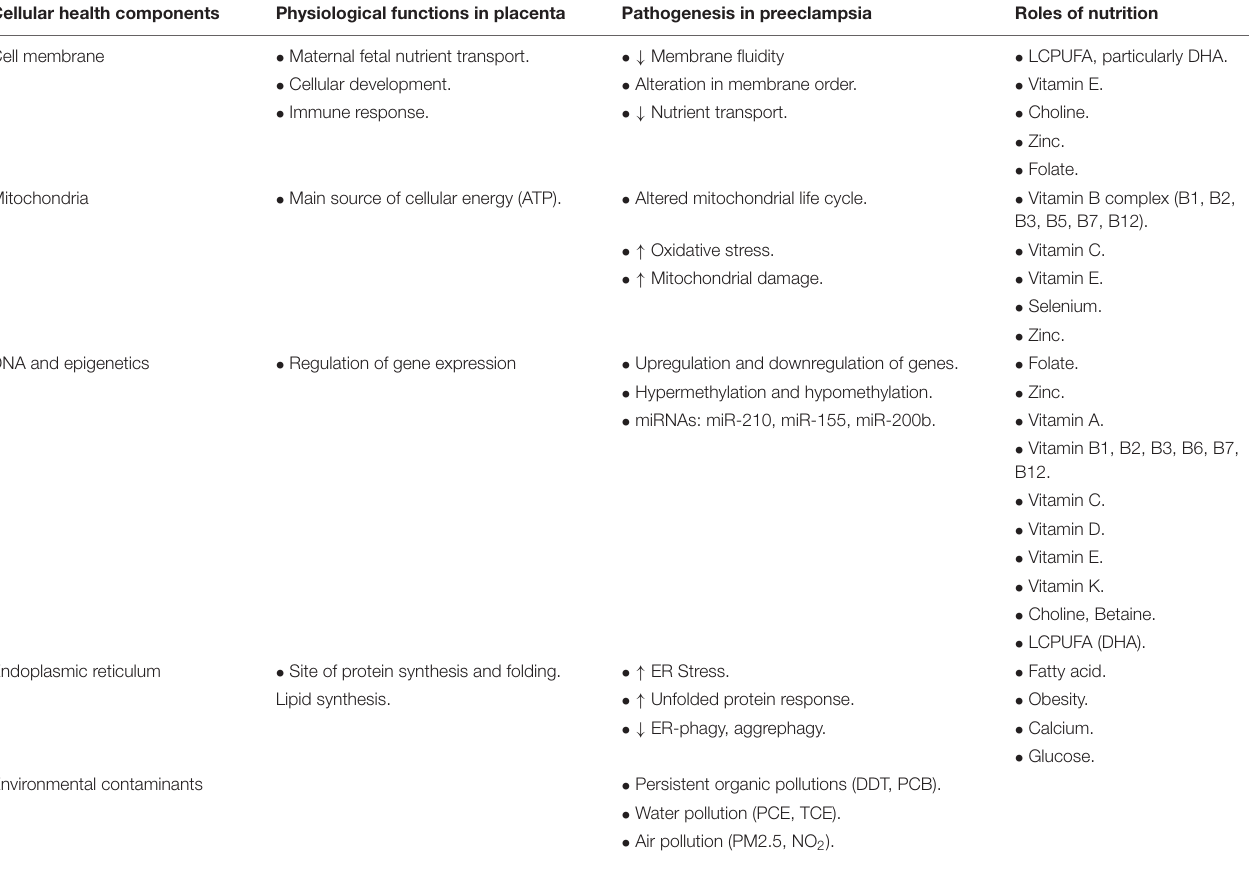
TABLE 5 | Summary table of the role of each cellular health